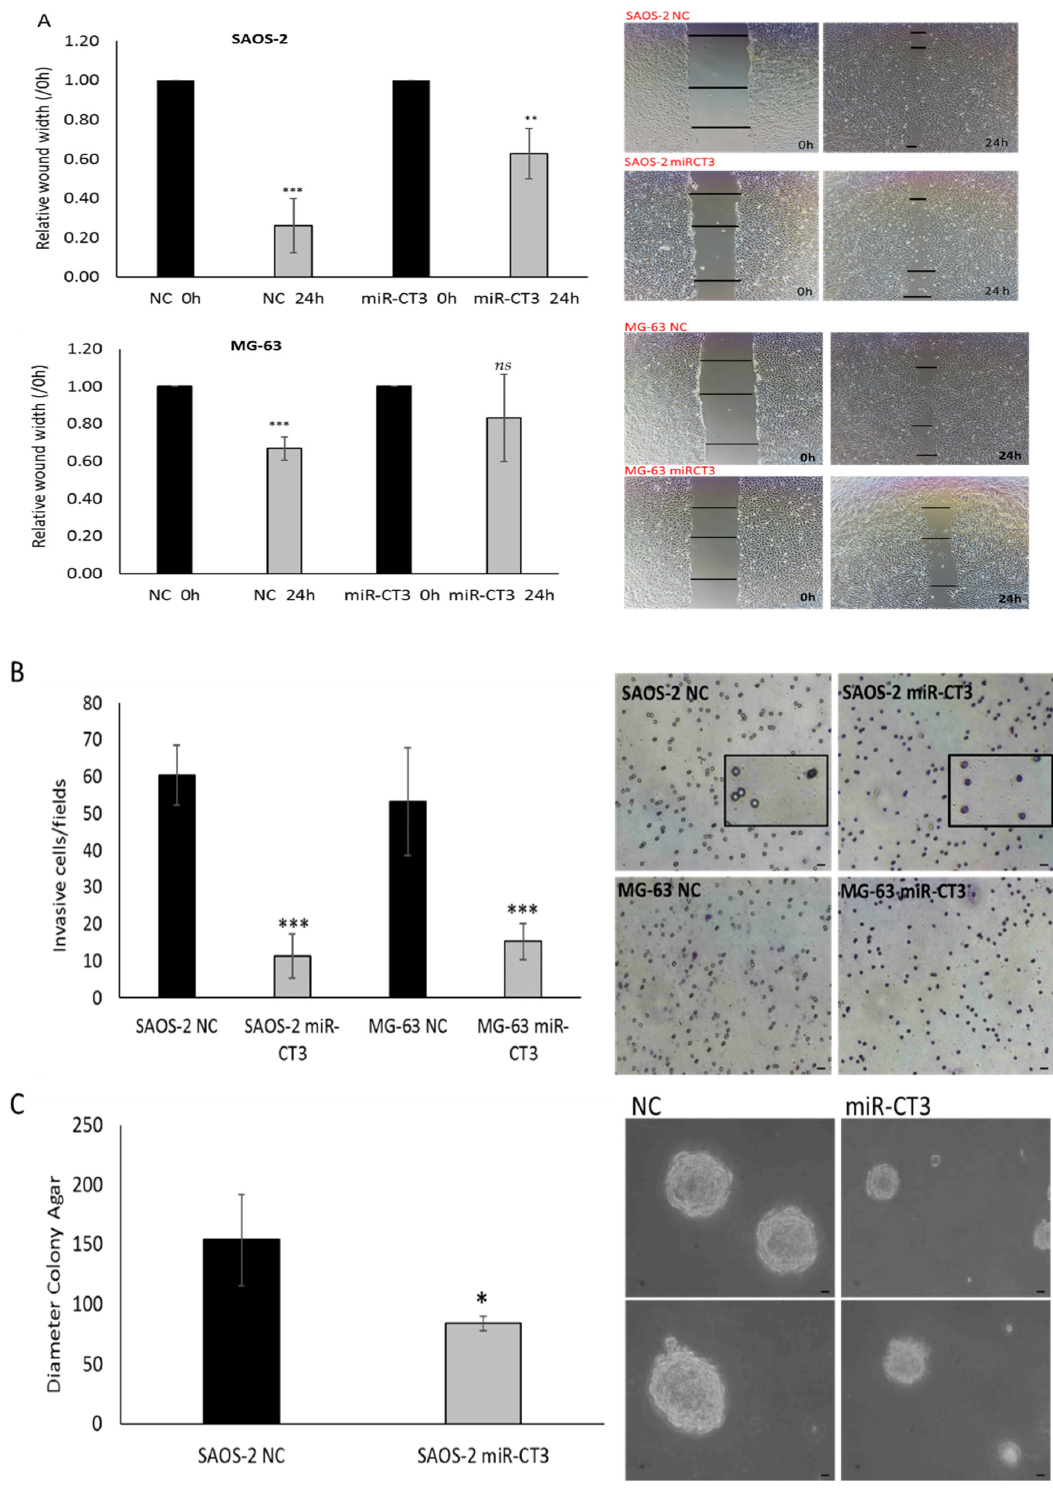
Figure 5. MiR-CT3 over-expression reduces invasiveness in OS cell lines. ( A ) Wound healing assays on the confluent layers of SAOS-2 (up) and MG-63 (down) cells transfected for 24 h with miR-CT3 mimics and NC. On the right of the panel: representative images of wound healing assays were acquired at 0 and 24 h after wounding, using a Nikon Eclipse Ti microscope. Data were calculated, for each condition, as the average of the widths of the gaps and normalized to initial wound width made at time oh. ( B ) Invasion assay of SAOS-2 and MG-63 cells transfected with miR-CT3 mimics and